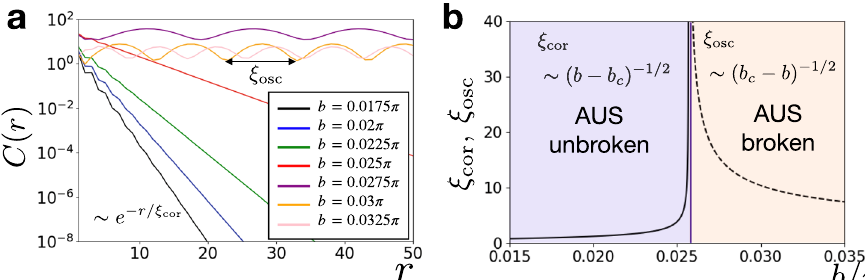
. a Generalized correlation function C ( r ) for 1 ; T